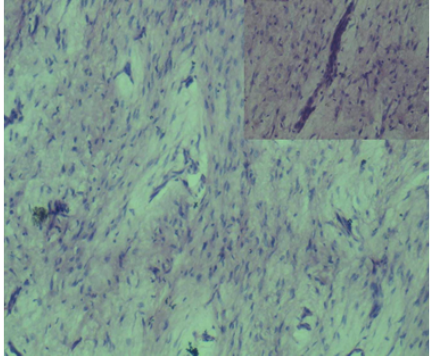
Figure 2: Odontogenic epithelial islands in the form of nests (10x). Inset showing epithelial islands in the form of long strands